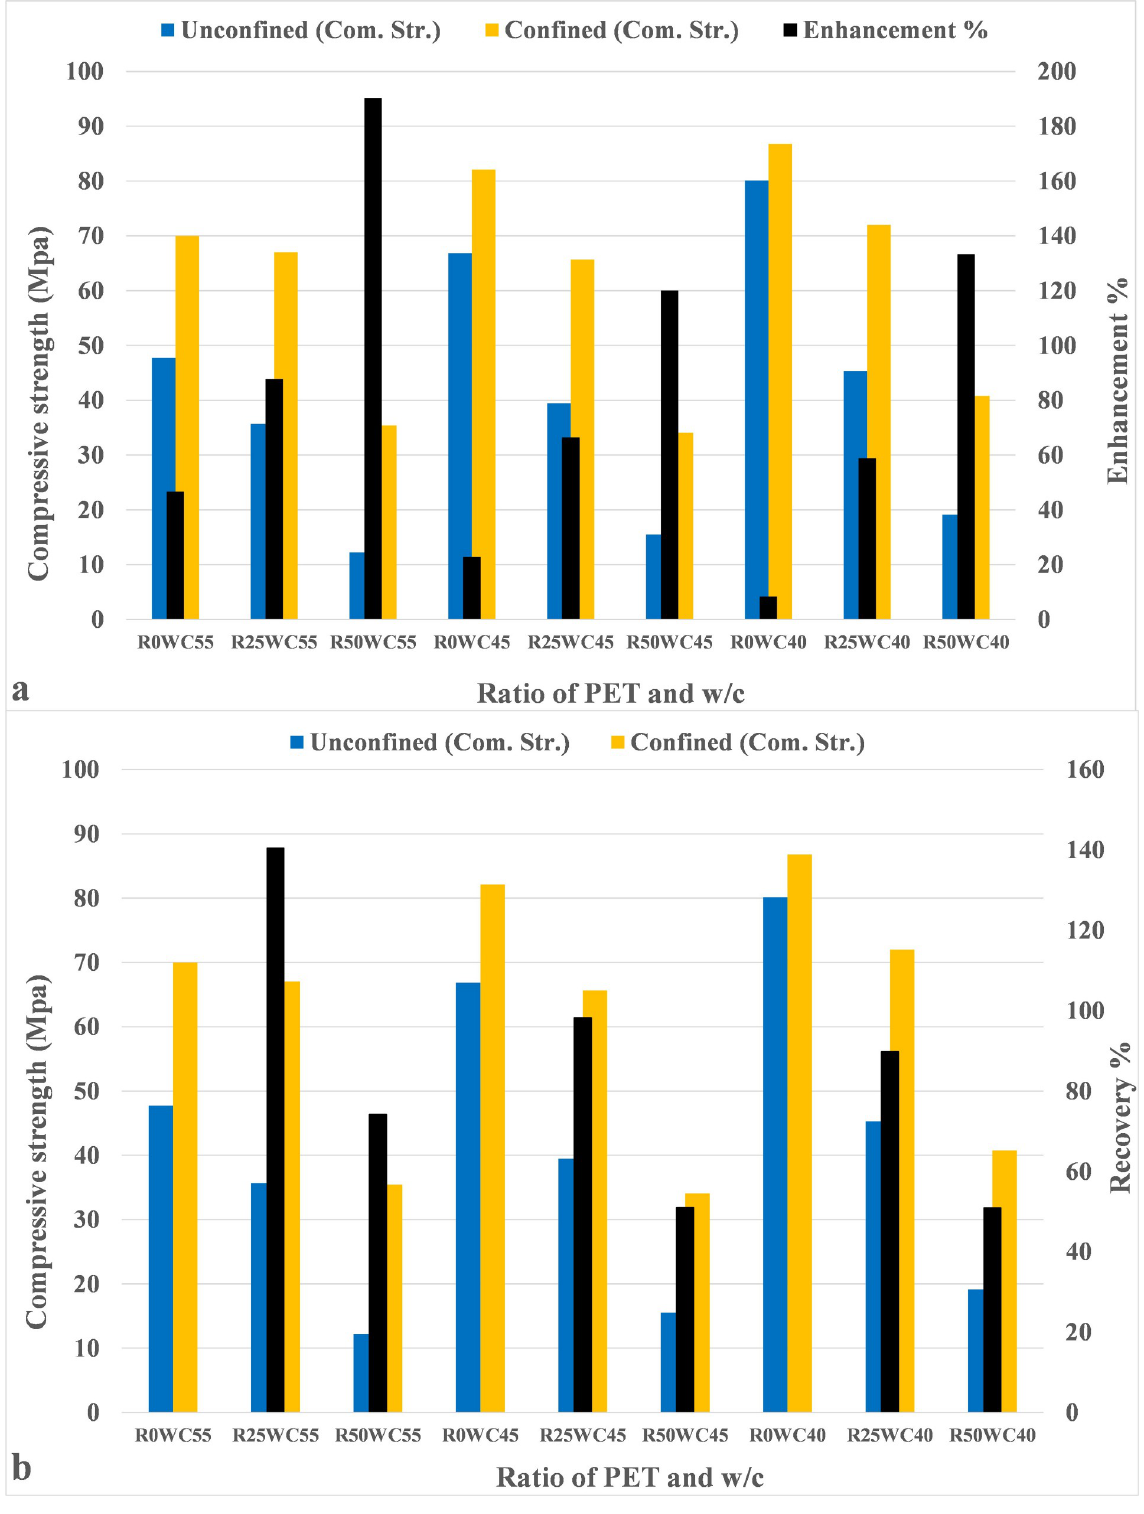
Fig 5. Influence of CFRP wrapping on strength: (a) enhancement; and (b) recovery.